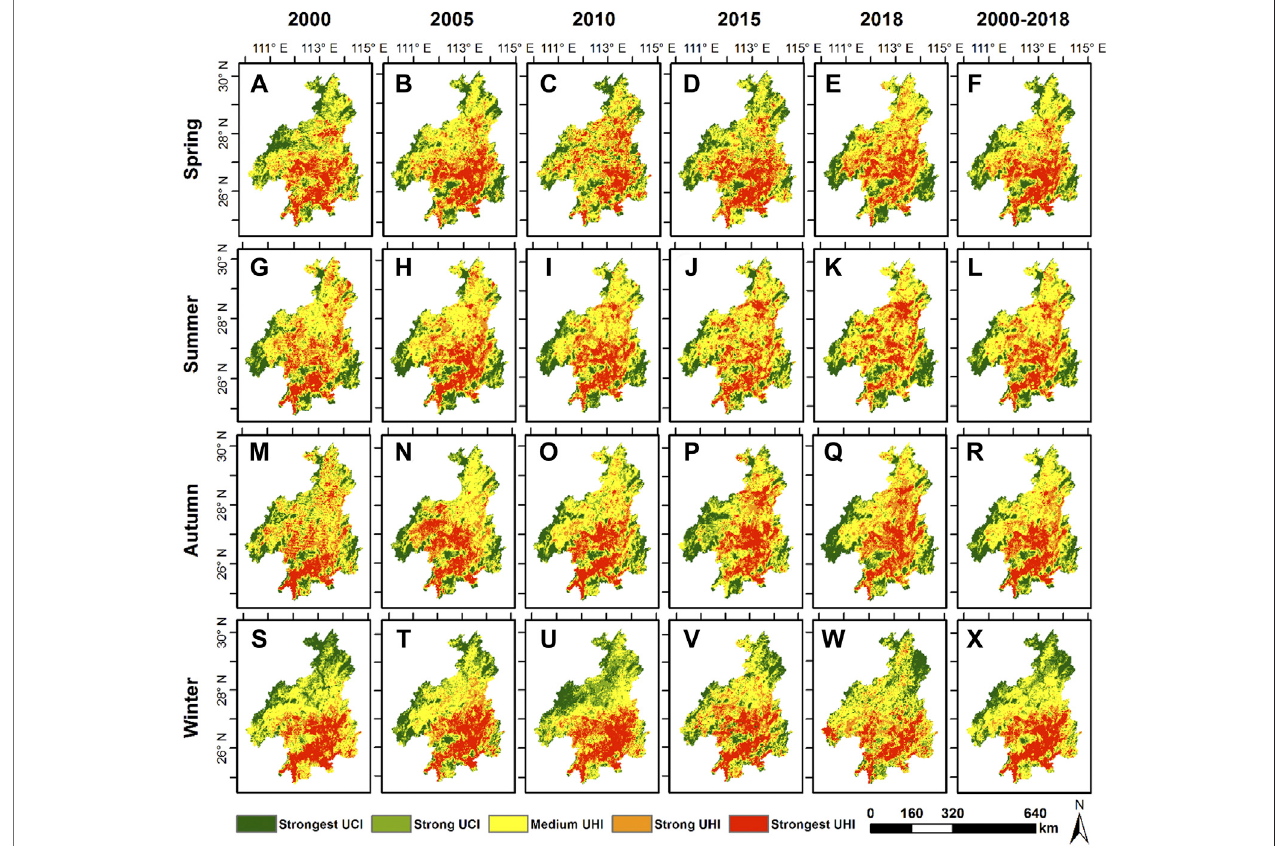
FIGURE 5 | Spatial distribution map of UHI effect for the (A – F) spring, (G – L) summer, (M – R) autumn, and (S – X) winter seasons during the period 2000 – 2018.